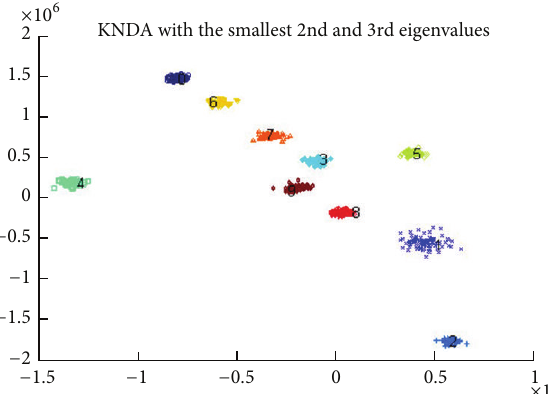
Figure4:The2-dimensionembeddingresultbyKNDAusingeigen- vectors corresponding to the 2nd and the 3rd smallest eigenvalues of